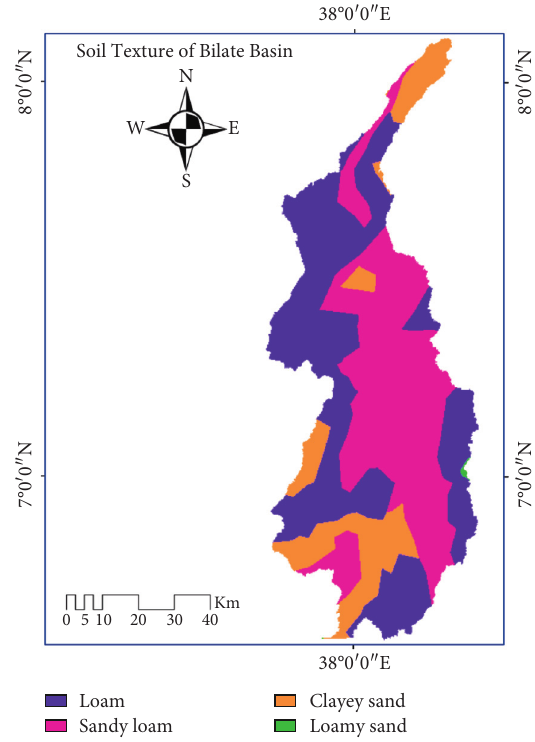
Figure 5: Soil map of Bilate basin.